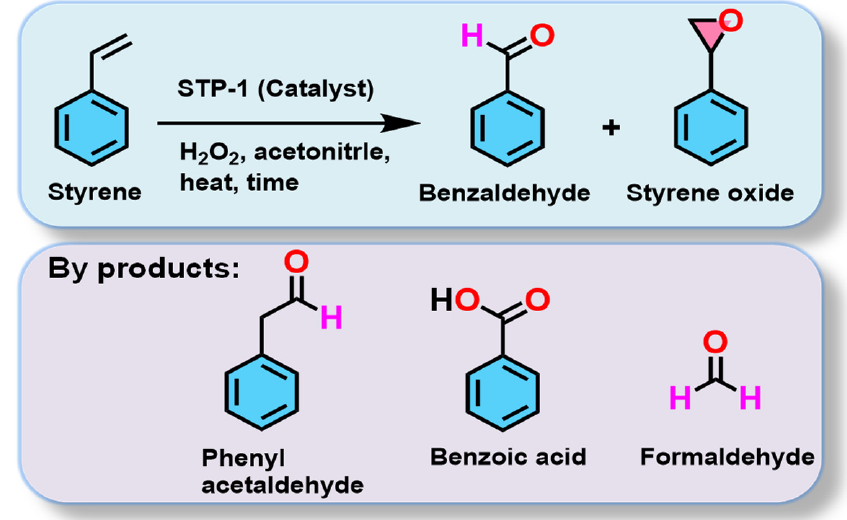
Scheme 1. Oxidation of styrene over Table 1. Optimization table for the liquid phase oxidation of styrene over STP-1.